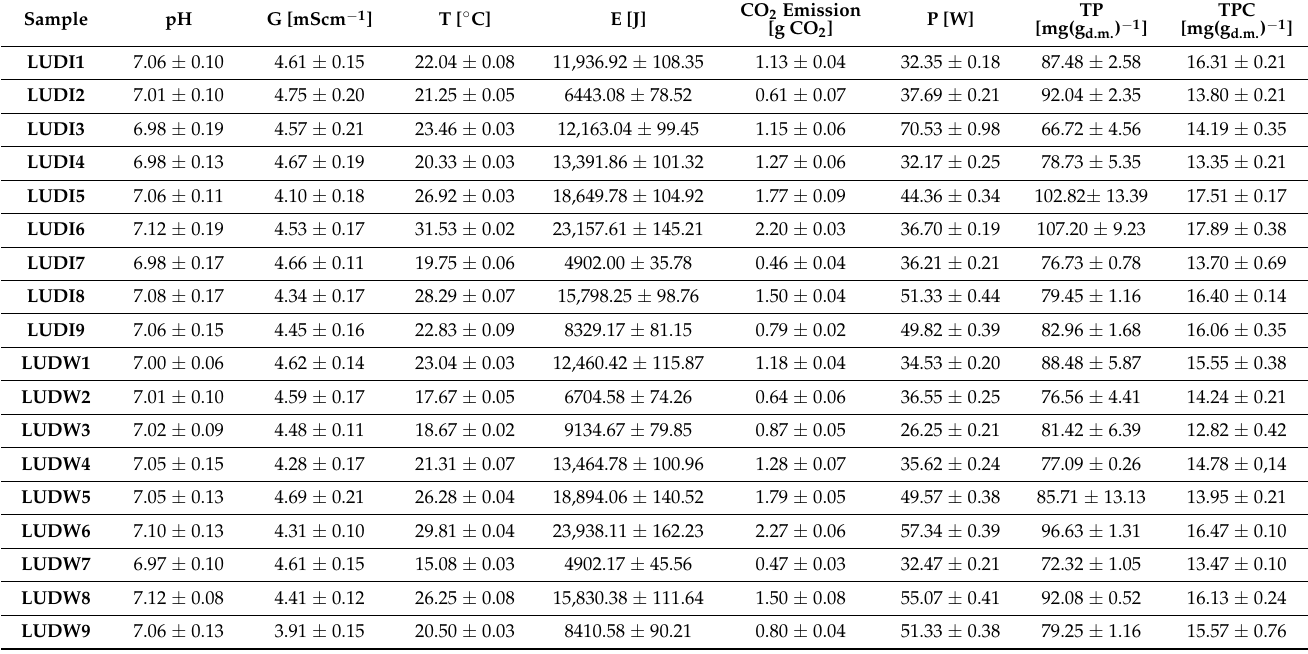
Table 3. Results of pH value, temperature, electrical conductivity, energy, CO 2 emission, power, total protein, and total phenols content for LUDI and LUDW samples.